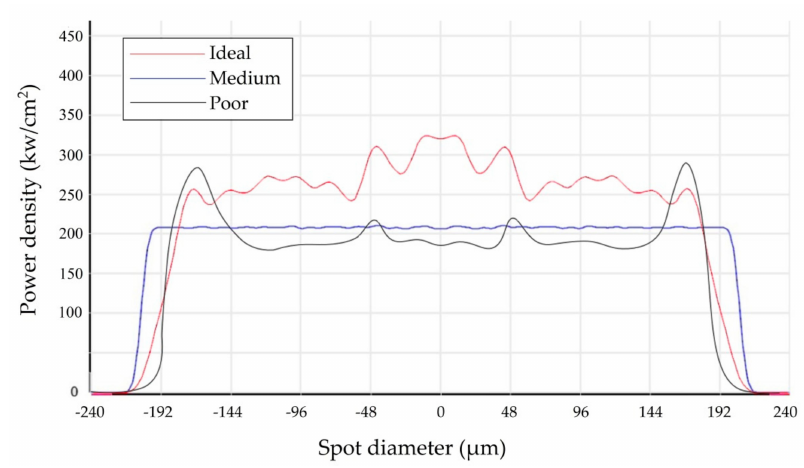
Figure 2. Quality of top-hat beam profile.